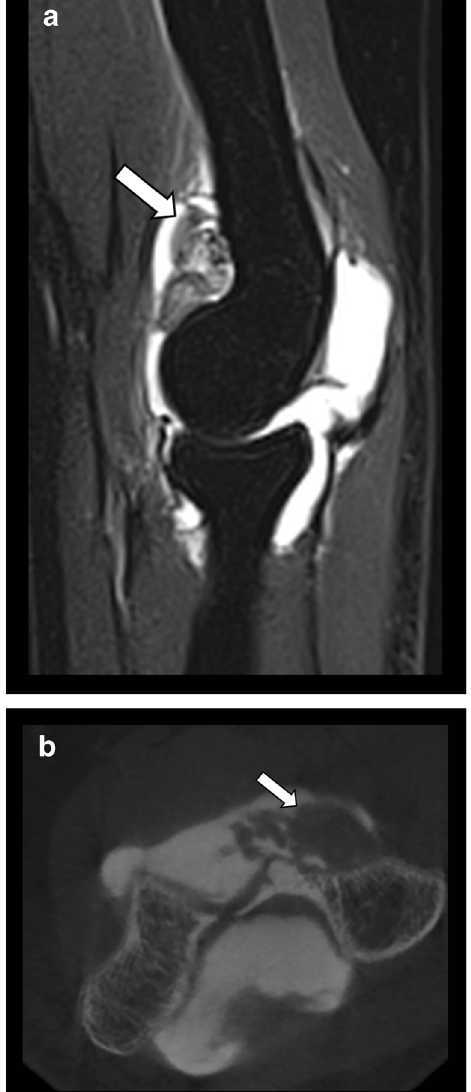
Fig. 12 Pigmented villonodular synovitis of the elbow. a . Sagittal T2 – WI fat suppressed MRI image presenting a mass within the joint cavity (arrow) with a low signal areas related to hemosiderin deposits. b . CBCT- A showing the presence of proliferative synovium (arrow) within the anterior part of the joint cavity